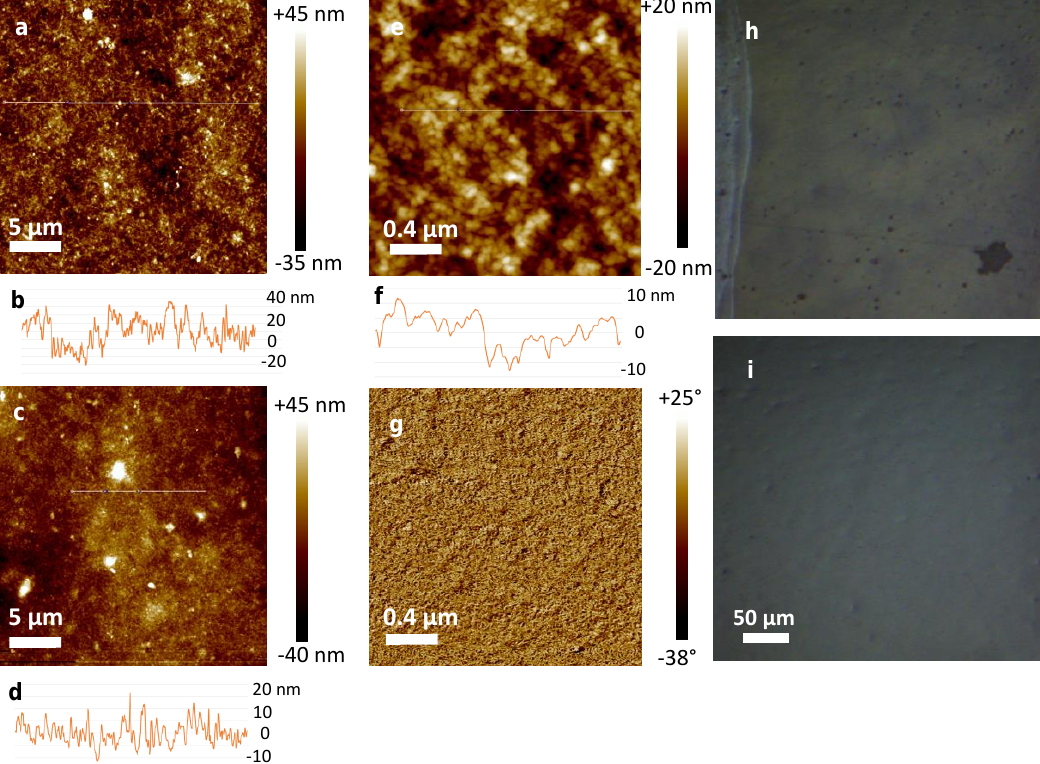
Figure 4. AFM topography ( a , c , e ) and phase ( g ) images with corresponding cross-sections roughness measurements ( b , d , f ) of a bare Kapton substrate ( a , b ) and poly[Ni-tto] / PVDF films deposited onto the Kapton ( c – g ); high magnification image ( e – g ) shows the film structure, which is predominantly composed of uniform 2–5 nm nanoparticles; optical microscopy images of bare Kapton ( h ) and poly[Ni-tto] / PVDF film ( i